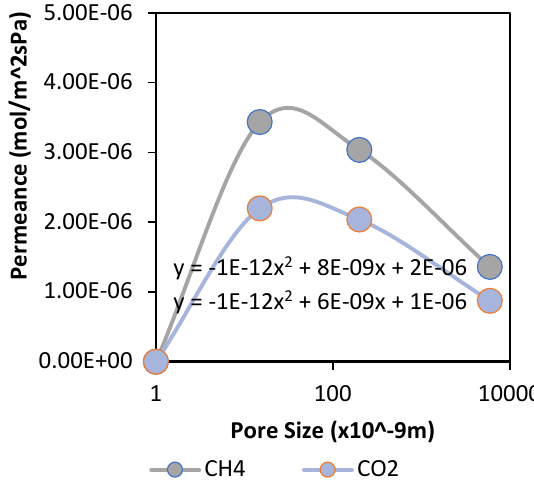
Figure 3. Effect of membrane pore size on gas permeance at 3 bar and 100 °C.